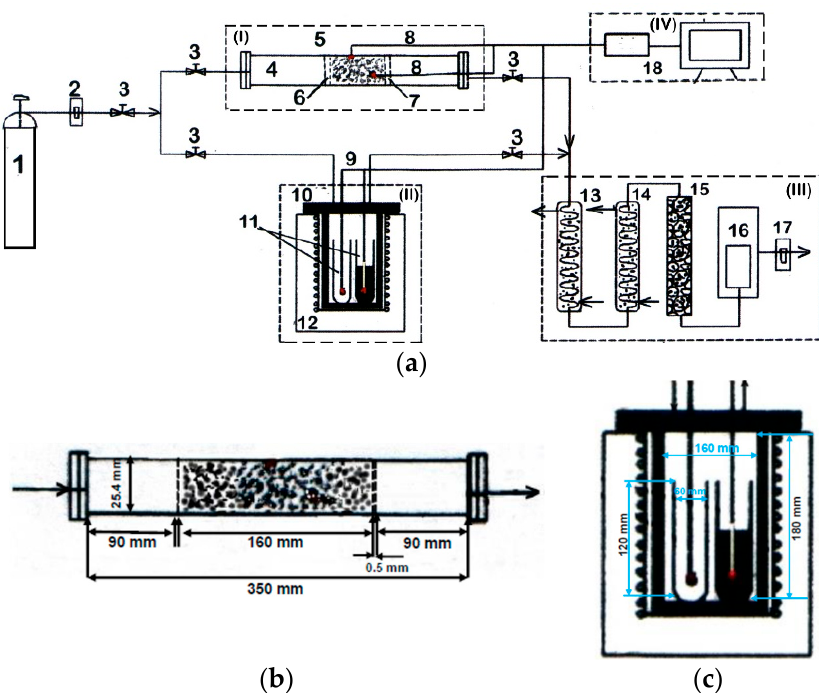
Figure 3. ( a )—Schematic diagram of the experimental system: (1) N 2 tank, (2) N 2 gas flow-meter, (3) valve, (4) stainless steel reactor; (5) electric tube furnace; (6,7)grate; (8, 9) thermocouples; (10) stainless steel reactor; (11) quartz tube; (12) electric furnace; (13,14) cooler; (15) filter with glass wool; (16) gas tank; (17) pressure gauge with gas flow-meter; (18)data acquisition unit; ( b )—stainless steel reactor-position (4) from the scheme; ( c )—quartz tube reactor-part (II) from the scheme.